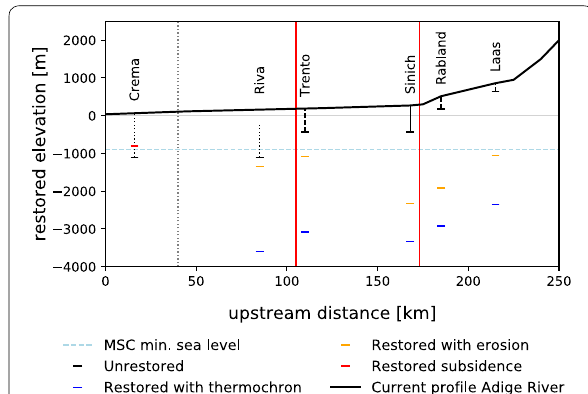
Fig. 8 Observed and restored depth of the erosional unconformities assuming a Messinian age and uplift since Messinian. The colours represent different uplift estimates. Thermochron refers to the exhumation model of Fox et al. (2016), sediment volumes refer to the